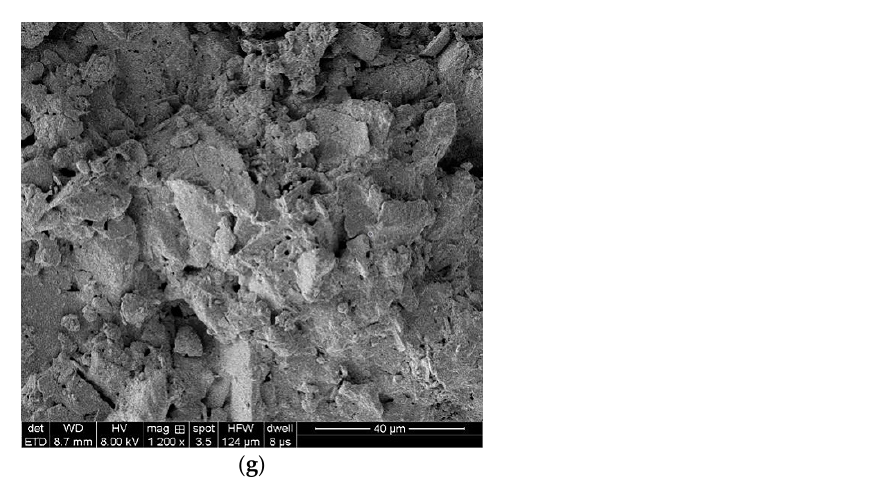
Figure 10. SEM images of Yili loess samples after different drying–wetting cycles ( a ) 0, ( b ) 1, (c) 3, ( d ) 5, ( e ) 10, ( f ) 20, ( g ) 30. Table 8. Microstructural parameters of Yili loess samples after different drying–wetting